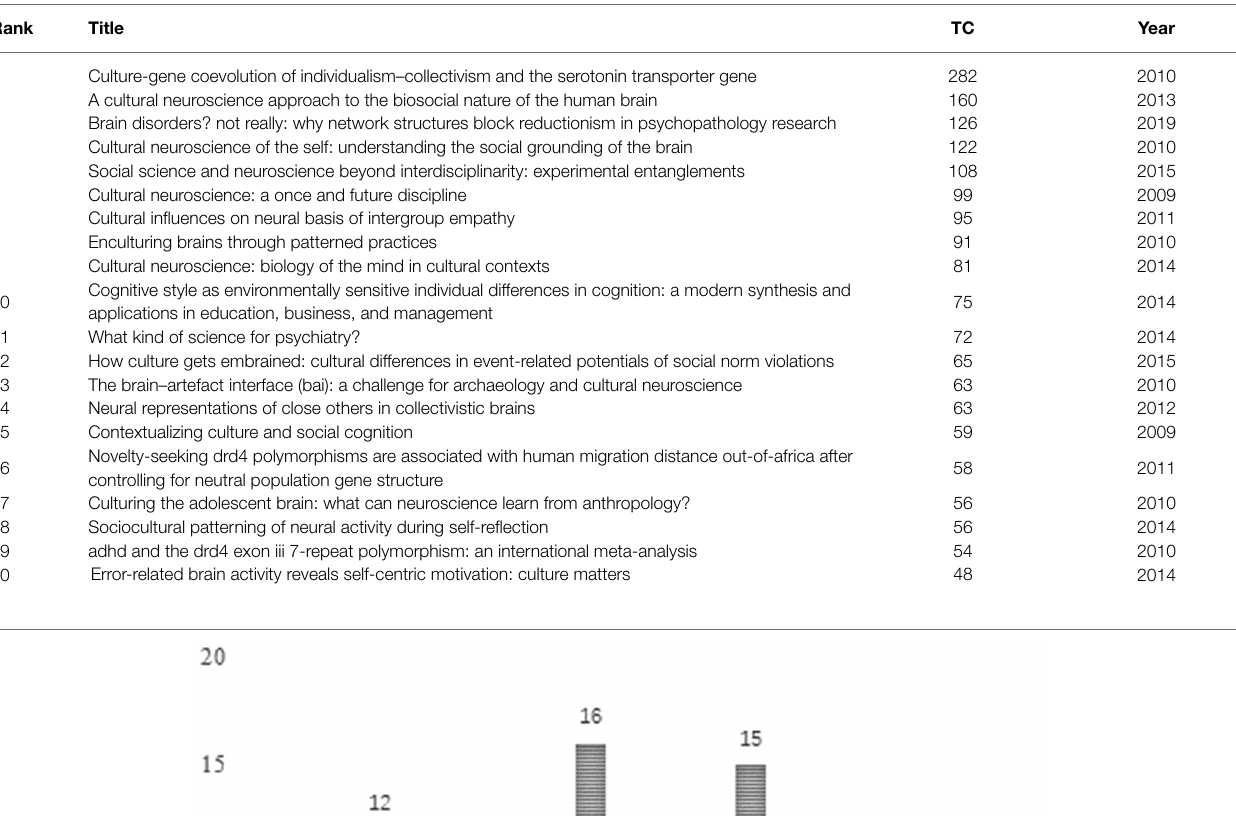
TABLE 5 | The 20 most influential